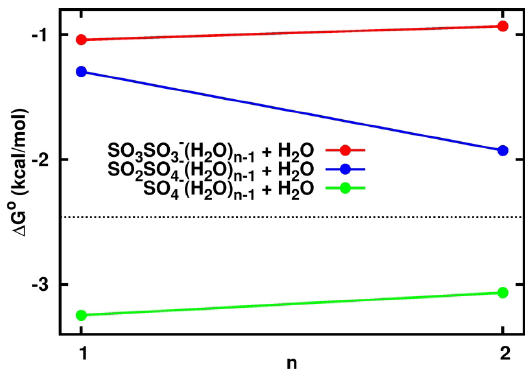
Figure 4. Hydration Gibbs free energy of the SO − SO 3 SO − ions at standard conditions. The black dotted line delimits 3 the domains where water condensation is favoured (below the dot- ted line) and where water evaporation is favoured (above the dotted